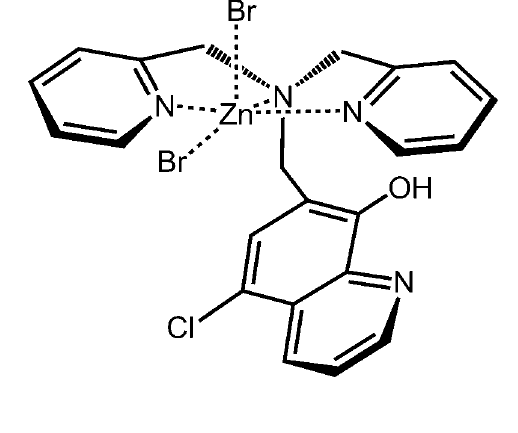
(22) and R 2 (14) rings. The C— 2 2